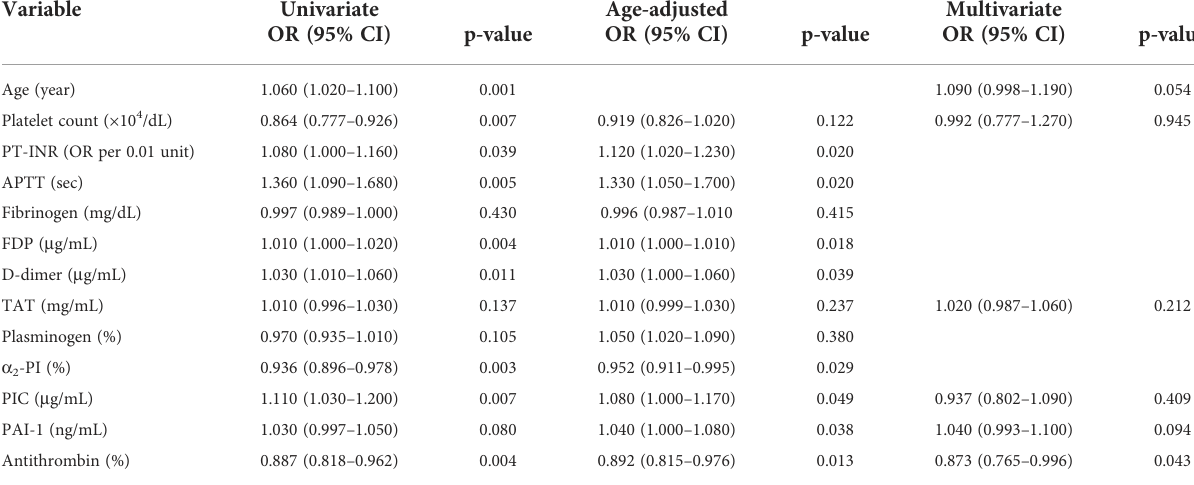
TABLE 3 Univariate, age-adjusted, and multivariate logistic regression analyses of biomarkers 1 h after injury.